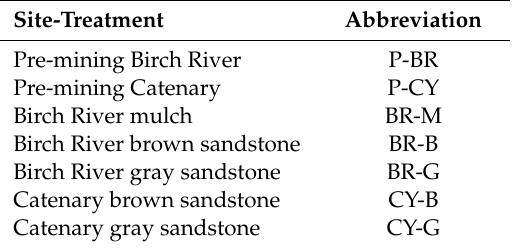
Table 2. Pre-mining native soil abbreviations and brown and gray mine soil